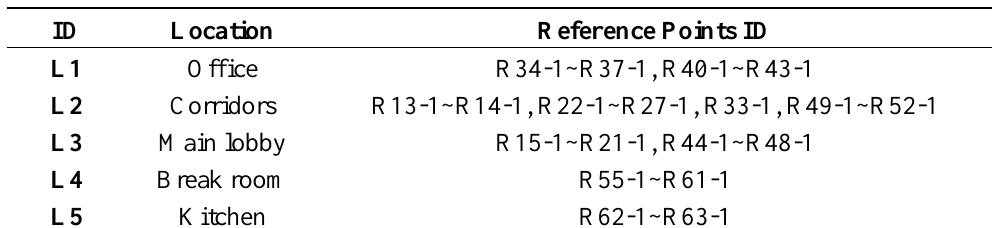
Table 5. Location